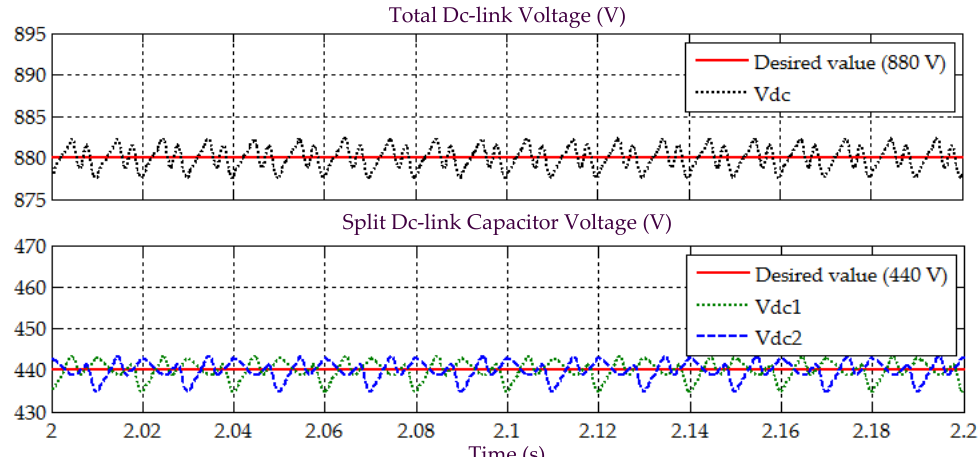
Figure 16. Simulation results obtained under Scenario C for Load 1, which include three-phase source voltage 𝑣 𝑆𝑎𝑏𝑐 , load current 𝑖 𝐿𝑎𝑏𝑐 , injection current 𝑖 𝑖𝑛𝑗𝑎𝑏𝑐 , source current 𝑖 𝑆𝑎𝑏𝑐 , and neutral current before and after mitigation, demonstrated by SAPF while applying the ( a ) proposed STF- dq 0 and ( b ) standard dq 0 techniques.